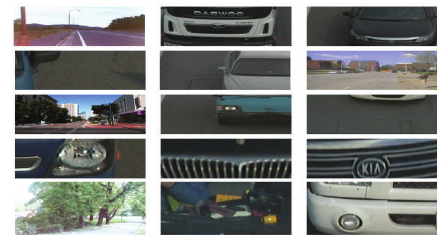
Figure 7: Negative sample images.